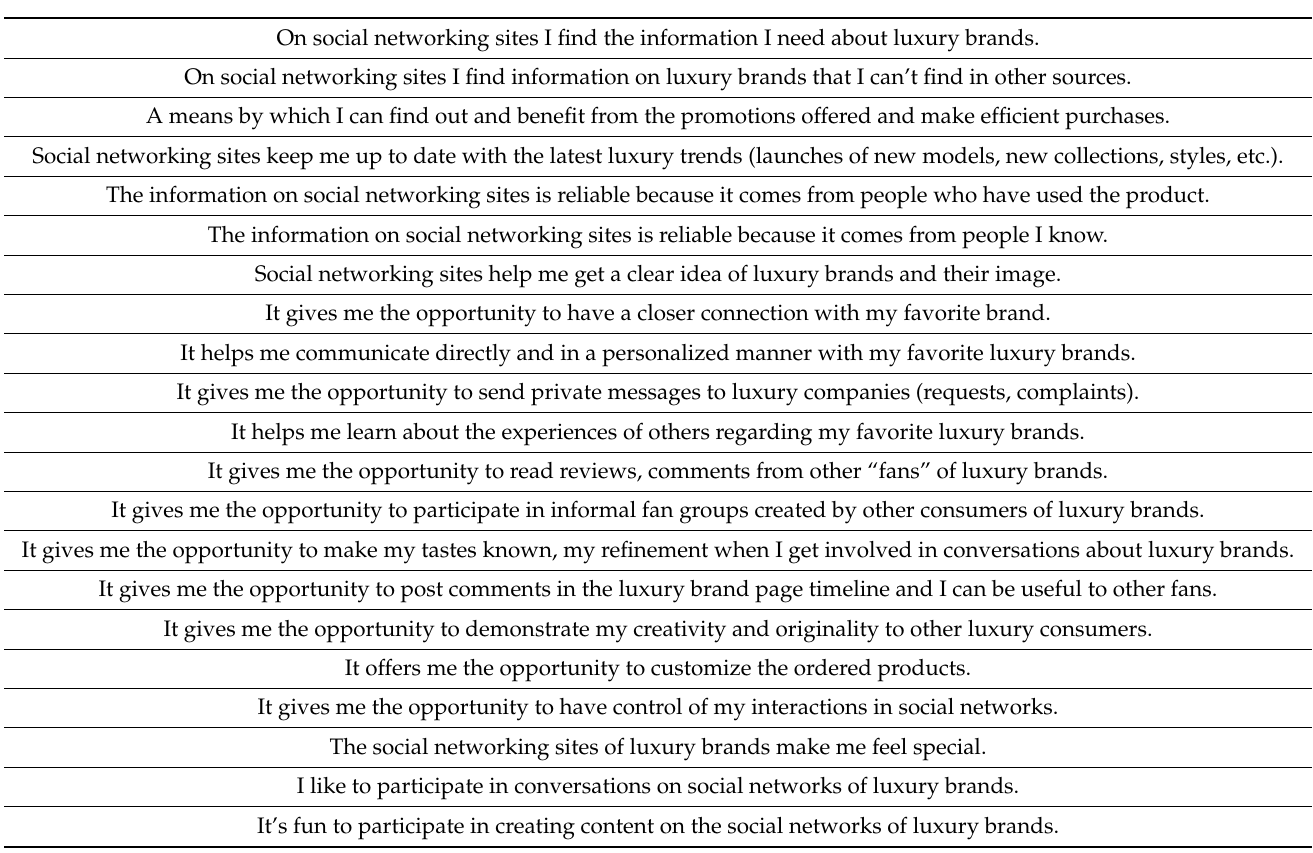
Table A3. The perceived value of social media